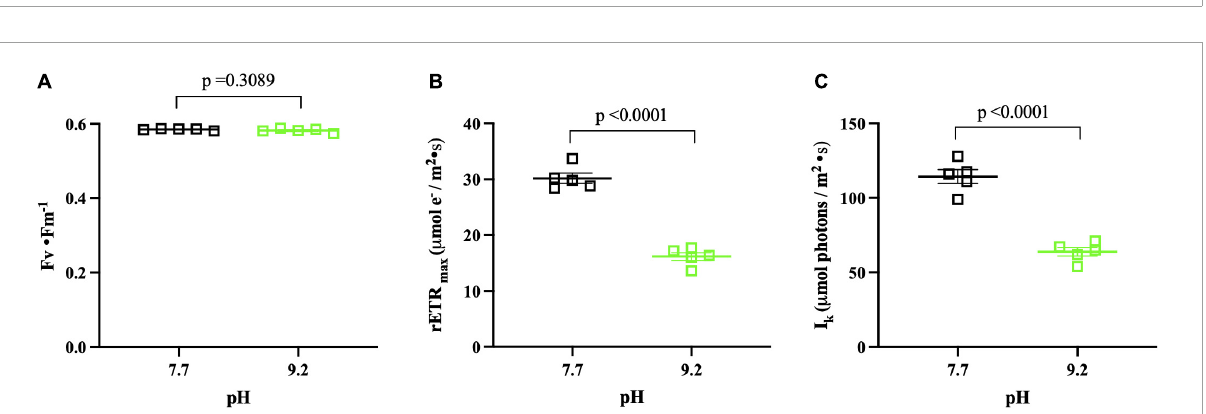
FIGURE5 PhytoPAM pH assay results ( n = 5) collected at (T f ). pH 7.7 replicates denoted by open, black squares. pH 9.2 replicates denoted by open, green squares. The group mean of treatment replicates indicated by the central bar and variability is indicated by error bars representing the standard error of the mean (SEM). (A) Fv • Fm - 1 of F. crotonensis filaments. (B) rETR max ( µ mol electrons/m 2 • s 1 ). (C) Photon flux at which light saturation of photosynthesis occurs I k ( µ mol photons m - 2 • s - 1 ). P -values are for comparisons between treatments.